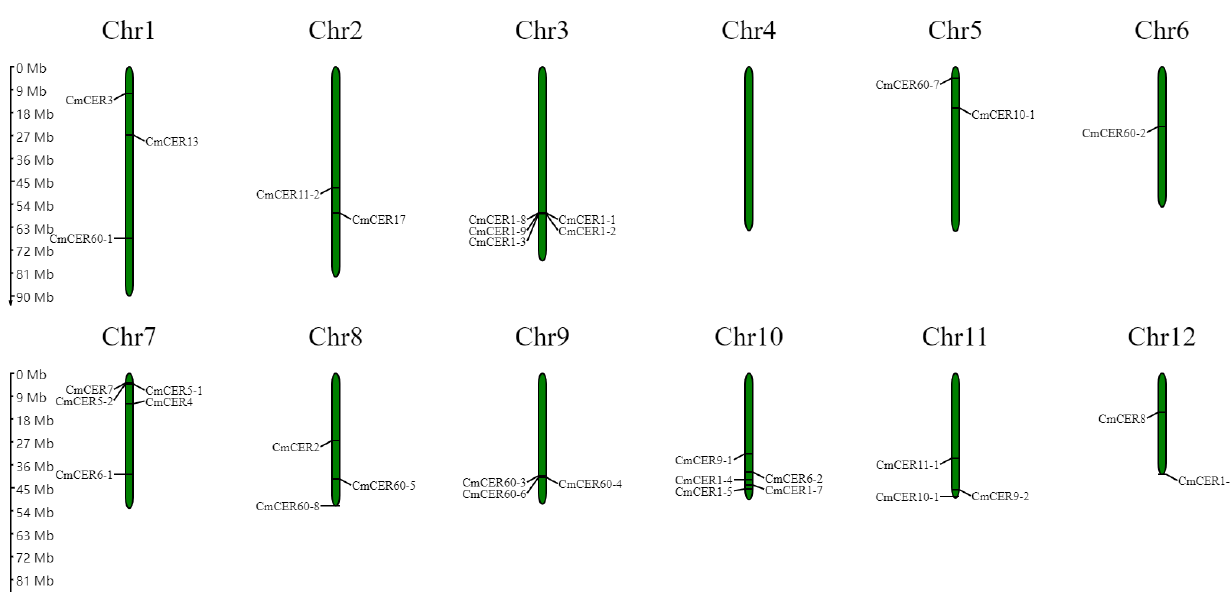
Figure 5. Chromosomal location of CmCERs